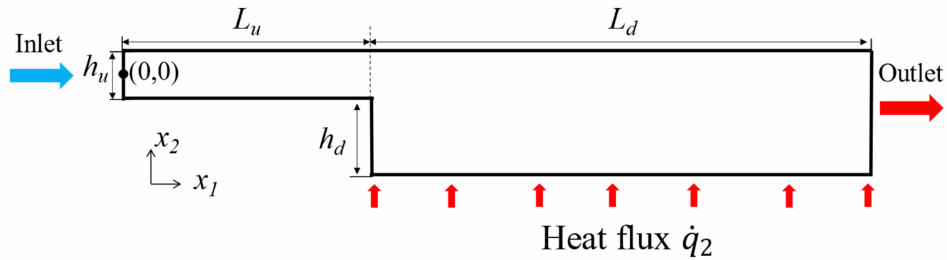
Figure 2. Two-dimensional schematic diagram of a horizontal backward-facing step. The schematic is enlarged vertically, for illustration purposes. The heat flux direction is indicated by the up- pointing